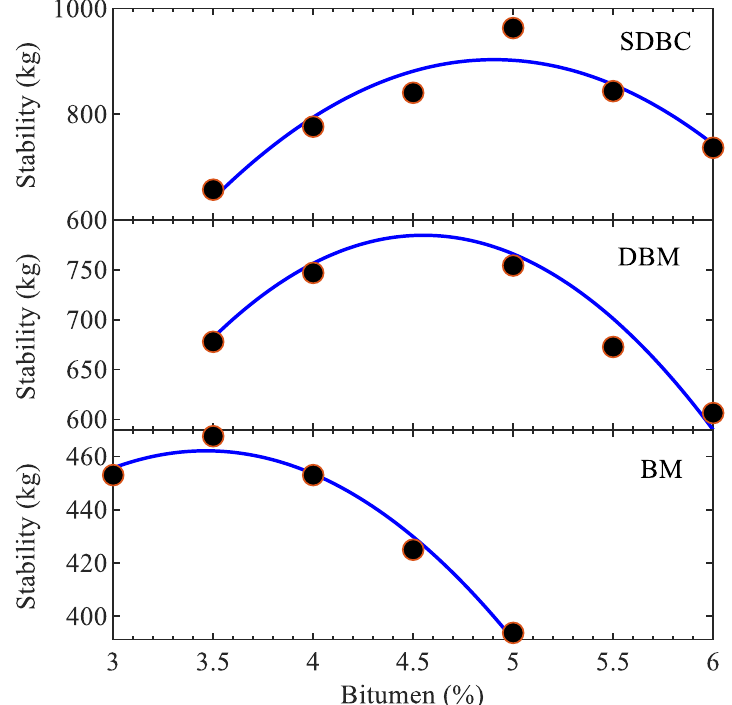
Fig. 6 Relations between Marshall stability with bitumen content for SDBC, DBM, and